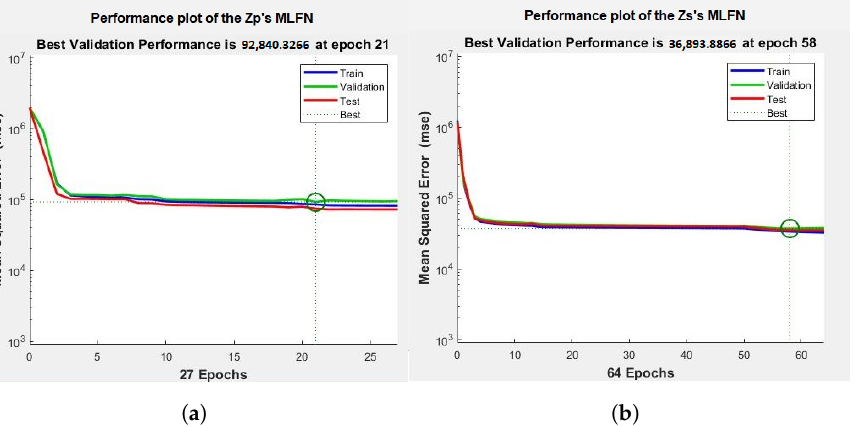
Figure 14. The performance plots of the ( a ) Z P and ( b ) Z S MLFN models, where the number of iterations is on the X-axis and the mean square error is on the Y-axis. The error reduction trends of the training, validation, and testing data appear in blue, green, and red colors, respectively.